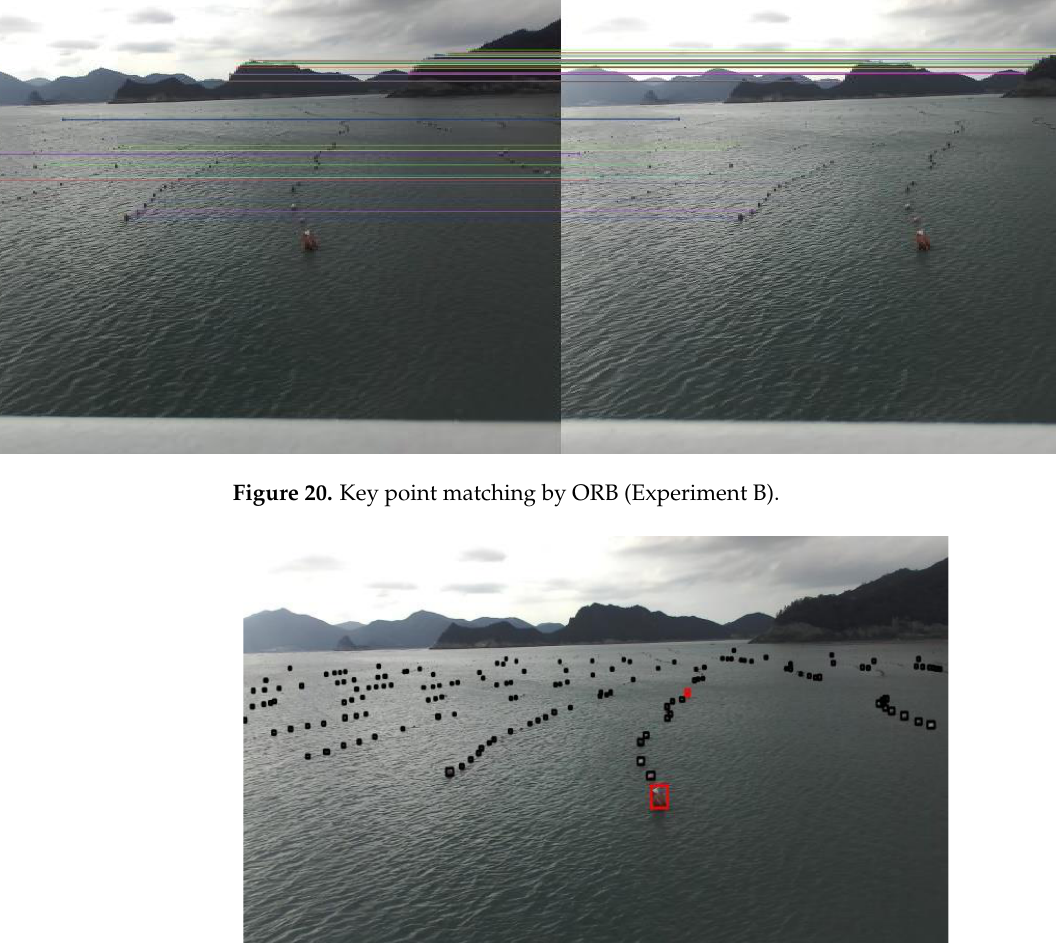
Figure 19. Area-based stereo matching results (Experiment B): ( a ) SSD and ( b ) NCC.